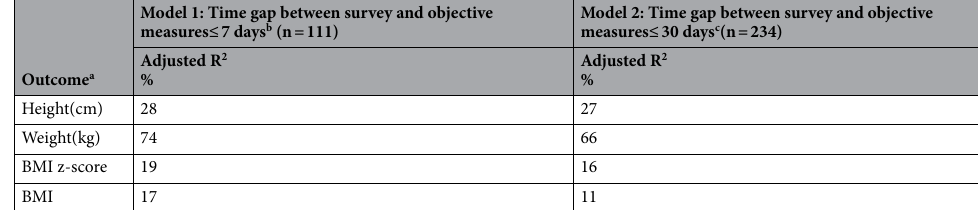
Table 3. Quality of correction models for height, weight, BMI z-score and BMI. a Selection of variables in the models is based on the univariate analysis (supplement Tables 3–4) and the Akaike Information Criterion. b Included survey reported measure, age and age 2 in the models of measured height, BMI z-score and BMI, respectively, included survey reported measure only in the model for measured weight; c Include survey reported Height, age and age 2 in the model of measured height, included survey reported weight and mother’s country of birth in the model of measured weight, included survey reported BMI z-score and household income in the model of measured BMI z-score, included survey reported BMI only in the model of measured